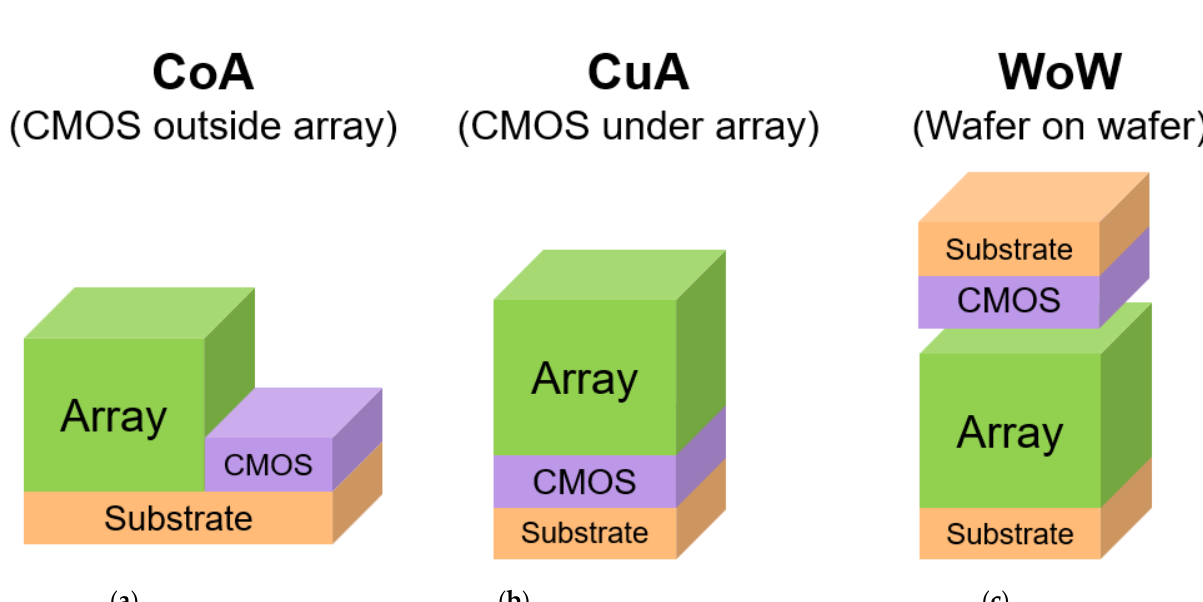
Figure 19. 3D NAND architectures for CMOS placement. ( a ) CMOS outside array (CoA); ( b ) CMOS under Array (CuA), ( c )